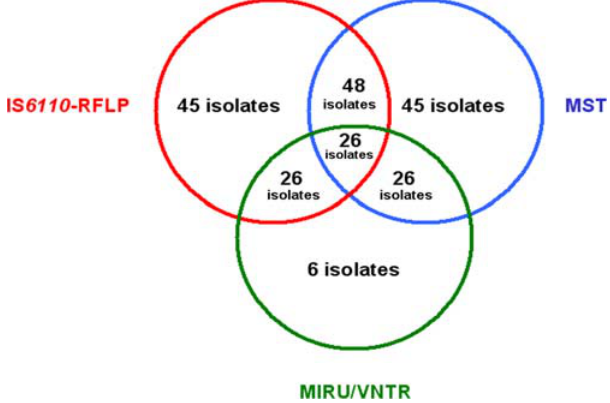
Figure 3. M.tuberculosis clustering by using MST, IS 6110 -RFLP and MIRU/VNTR. M. tuberculosis isolates were genotyped by using IS 6110 -RFLP (93 isolates, red circle), MIRU-VNTR methods (32 isolates, green circle) and MST (93 isolates, blue